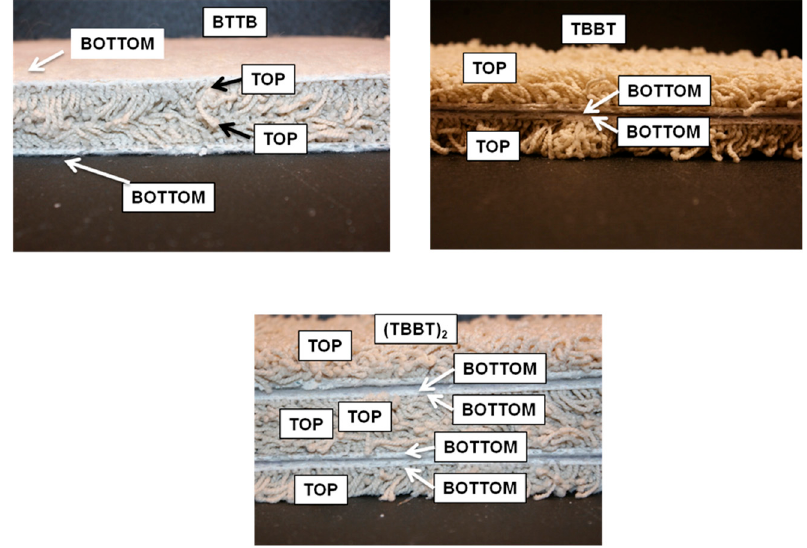
Figure 2. Images of carpet configurations used for Vacuum assisted resin transfer molding (VARTM).